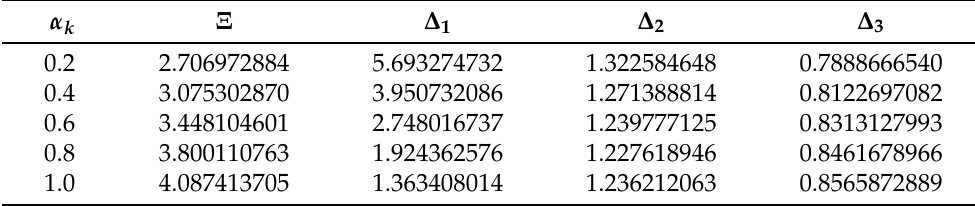
Table 3. Numerical values of Ξ and ∆ i , i = 1,2,3, for α k ∈ { 0.2,0.4,0.6,0.8,1.0 } when φ k ( t ) =